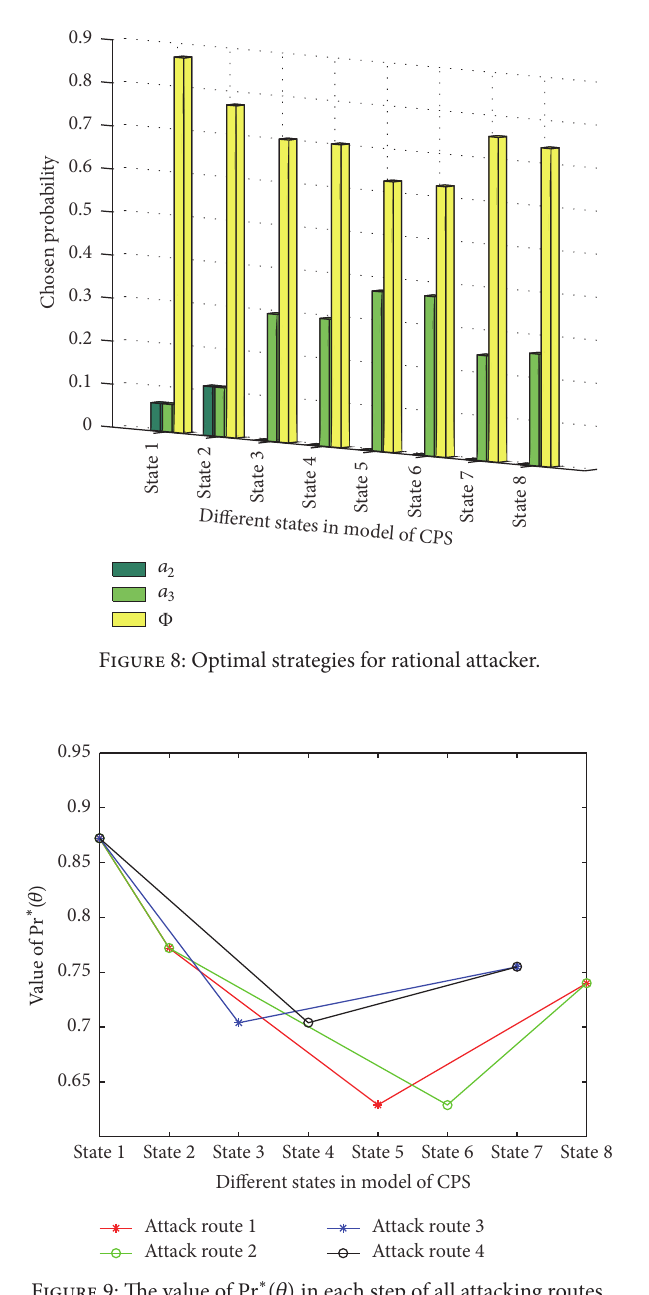
Figure 9: The value of Pr ∗ (𝜃) in each step of all attacking routes.